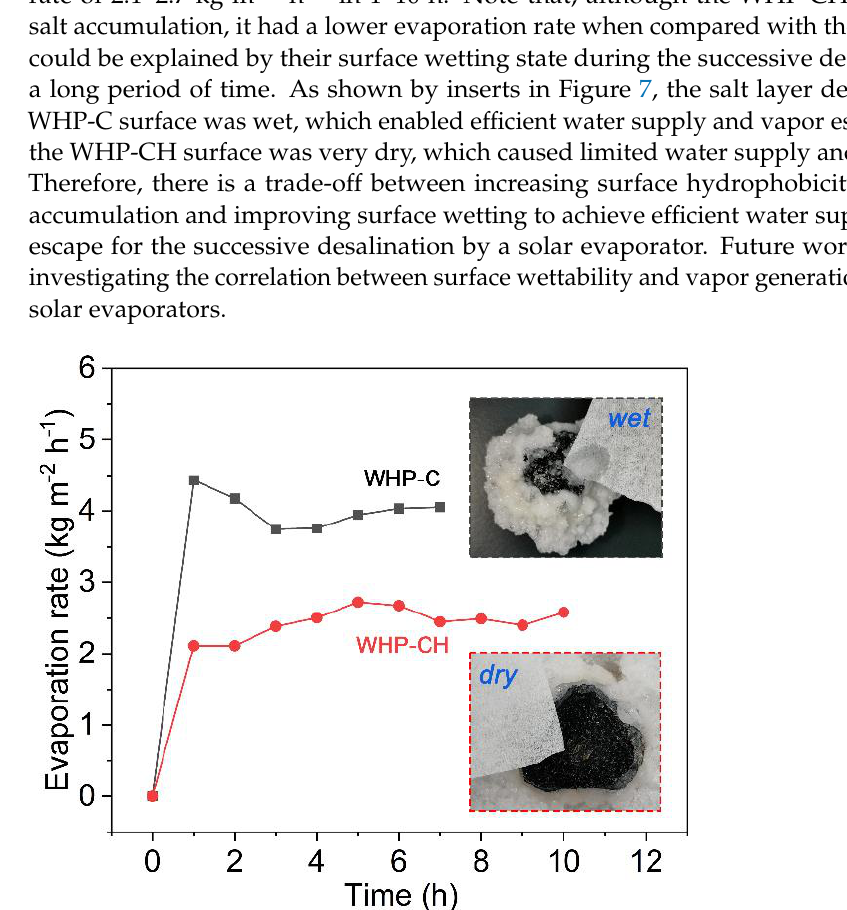
Figure 7. The evaporation rates of WHP-C and WHP-CH under 4 sun irradiation when treating 30 wt% NaCl solution over a long period of time. Inserts are the photos of WHP-C and WHP-CH after long-term desalination, showing a wet salt layer and a dry surface,